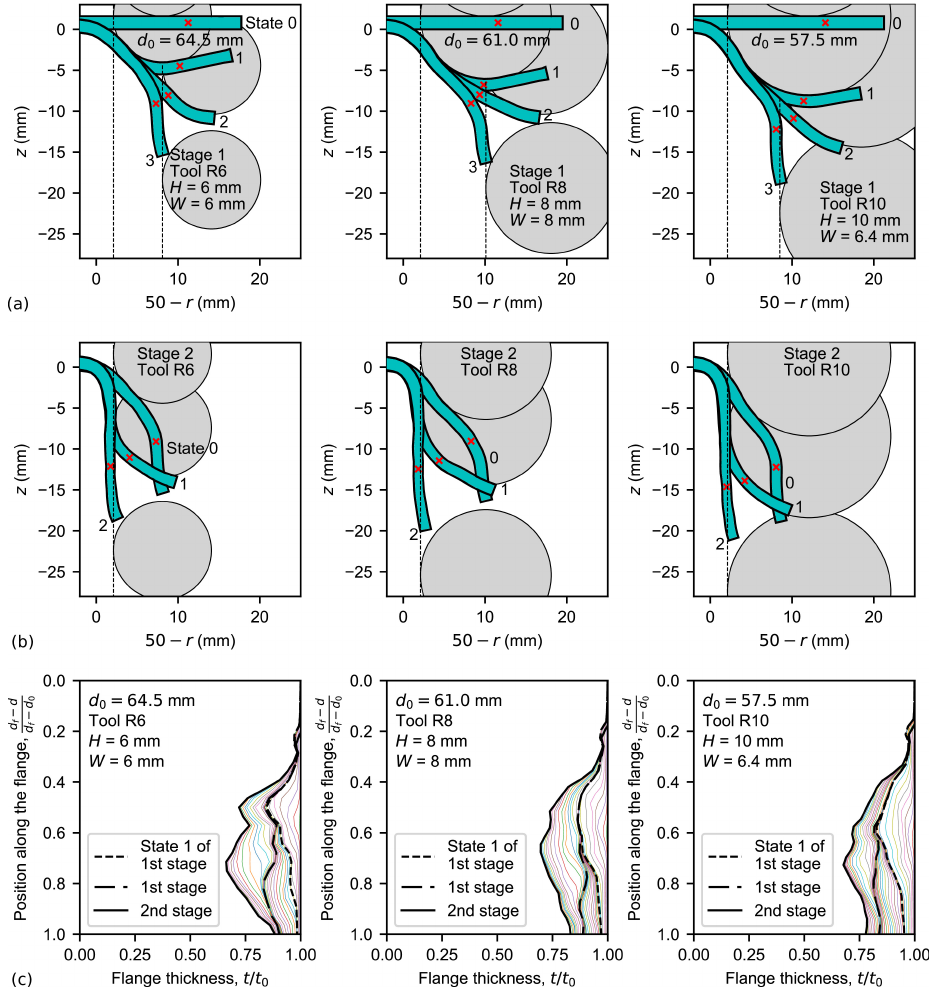
Figure 12. Simulations of hole-flanging by the proposed two-stage SPIF process: flange profile and tool position in ( a ) stage 1 and ( b ) stage 2; and ( c ) flange